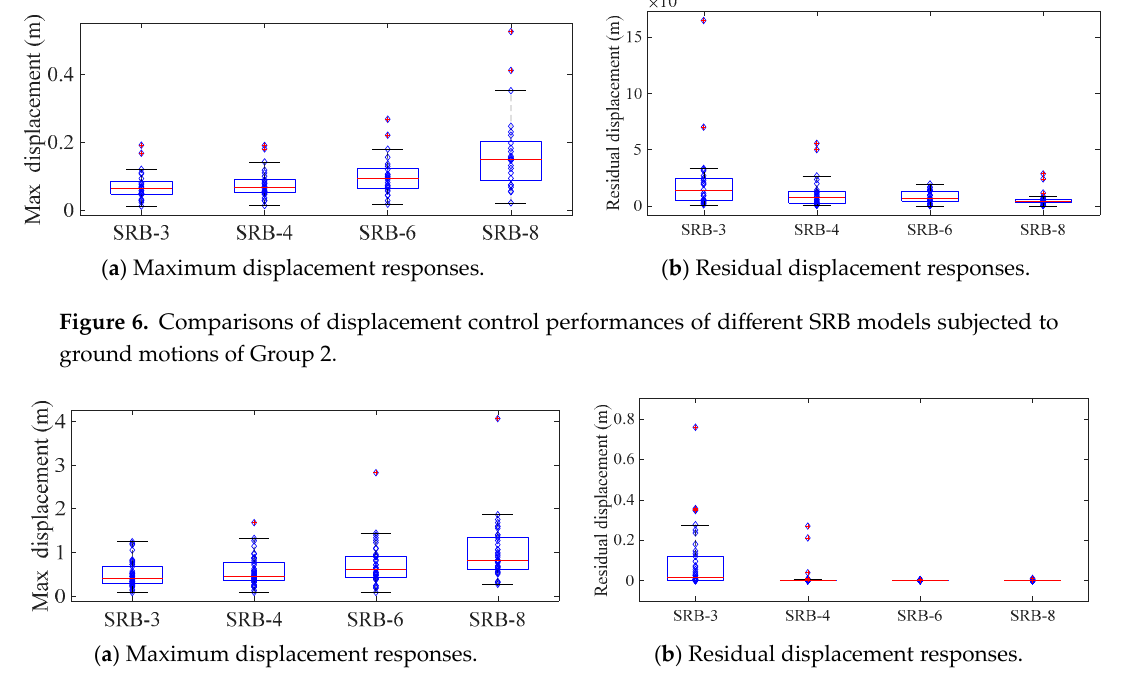
Figure 7. Comparisons of displacement control performances of different SRB models subjected to ground motions of Group 3.